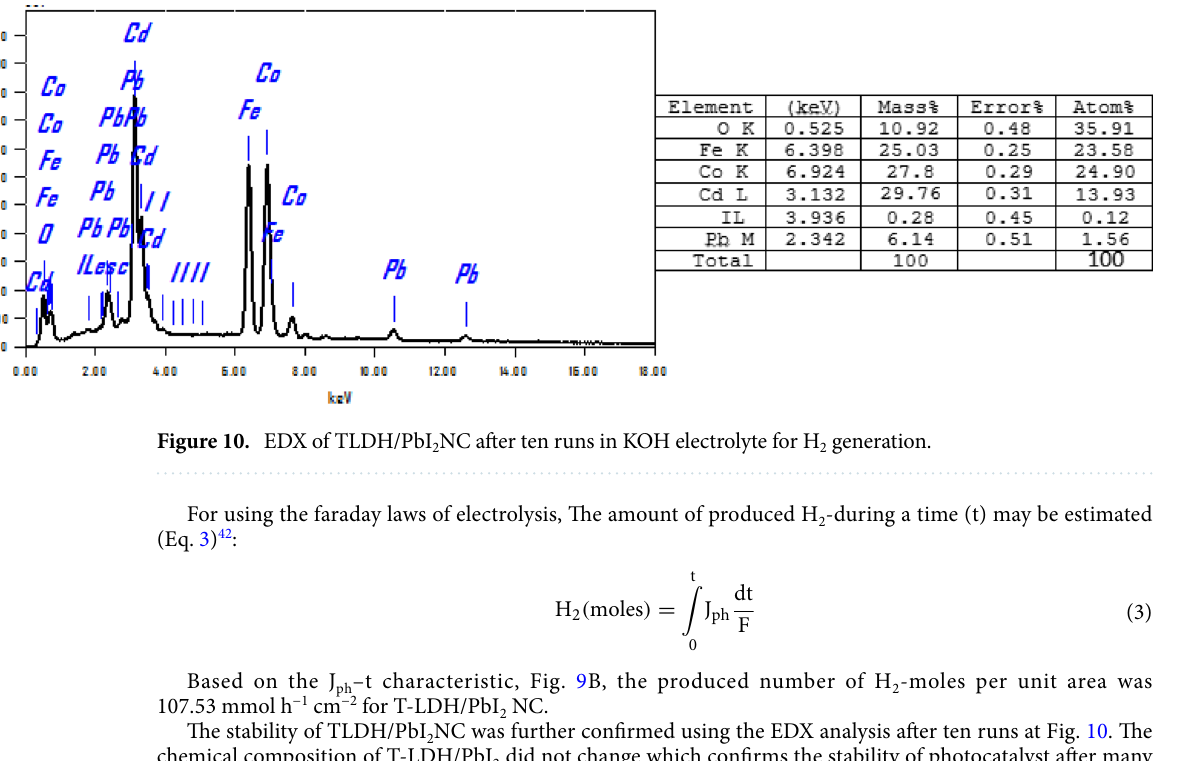
Fig. 11A. The PEC behaviors in 0.3 M KOH (100 ml) solution at 25 °C and increment 1 mV/at different optical filters were studied. We noticed The alteration of the monochromatic light changes the J ph value. The behavior of the T-LDH/PbI 2 NC photoelectrode under the monochromatic illumination can be significant related to its absorbance response for different wave lengths light and its ability to absorb a large part of visible sunlight. Generally, IPCE (incident-photon-to-current conversion efficacy) and ABPE (applied bias-photon-to-current efficacy) are main factors for qualifying the PEC solar hydrogen generation. IPCE value was measured at dif- ferent wave length filters for determining the actual number of charge-carriers that related to the generated photocurrent per incident photon. Using the power density (P (mW cm −2 )) and the wavelength (λ (nm)) of the monochromatic light as shown Fig. 11B, the IPCE is given using Eq. (4) 43